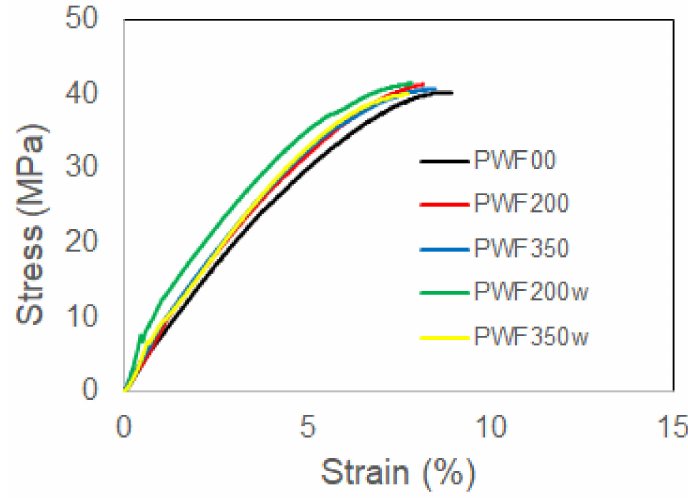
Figure 5. Stress-strain curves of PWF type composites: PWF00, PWF200, PWF350, PWF200w, and